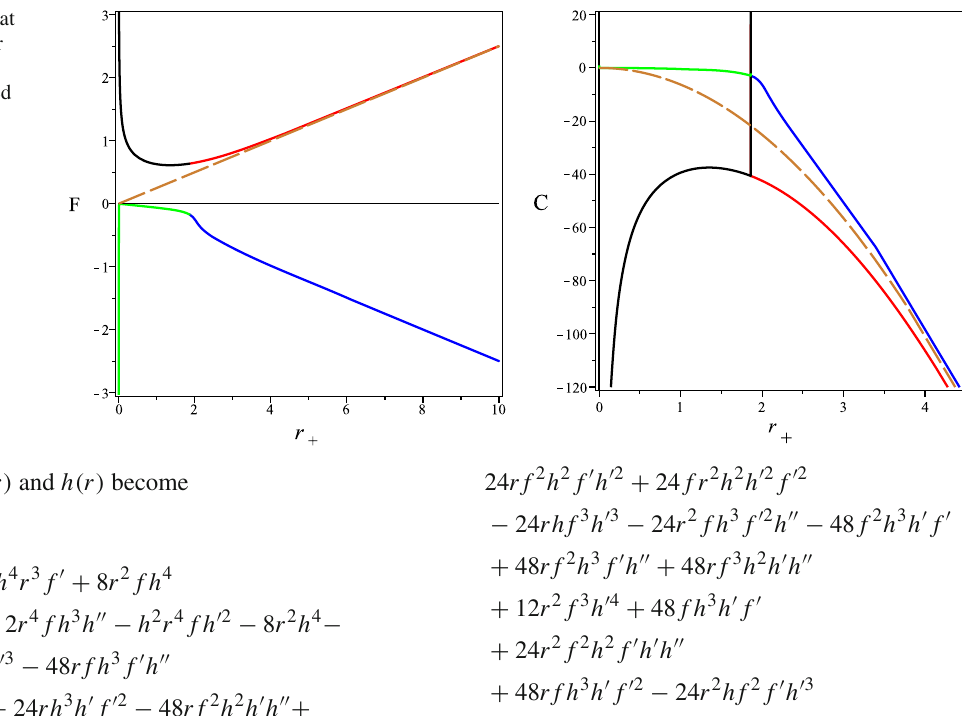
Long dashed lines are the results of our method and dotted lines are for the paper [17,18]. The orange long dashed lines related to the Schwarzschild’s black hole